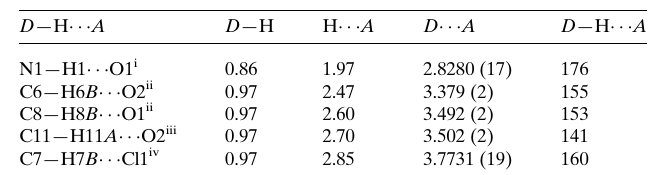
Table 1 Hydrogen-bond geometry (A˚ , (cid:2) ).